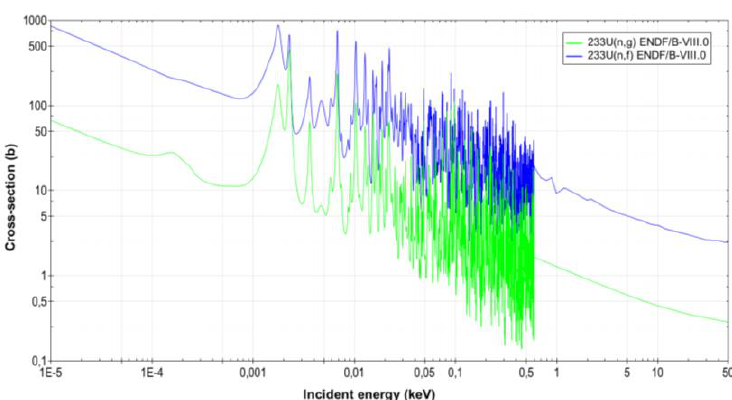
Fig. 2. 233 U fission and capture cross section in